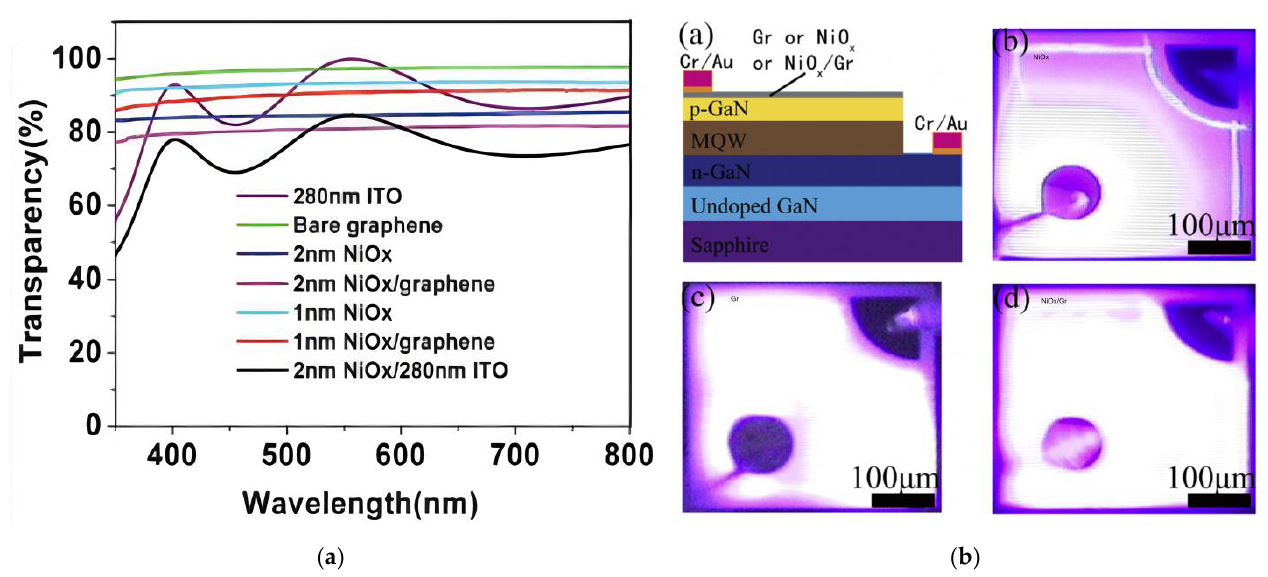
Figure 9. Graphene with NiO x interlayer as TCSL in GaN-based MQW LEDs: ( a ) transmission spectra of different layer combinations: NiO x (1 nm and 2 nm), NiO x /graphene, graphene, NiO x /ITO, and 280 nm ITO; ( b ) cross-sectional image (upper left) and EL images of LEDs with different TCSLs: NiO x (upper right), graphene (lower left), and NiO x /graphene (lower right). ( a ) Reproduced with permission from [35] Copyright 2012 The Royal Society of Chemistry. ( b ) Reproduced with permission from [15]. Copyright 2015 Elsevier